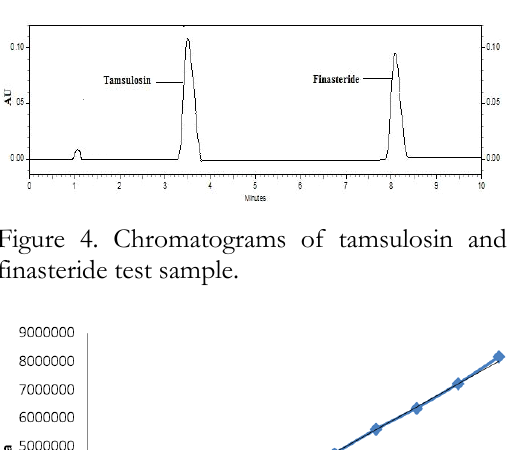
Figure 3. Chromatograms of tamsulosin and finasteride reference sample.